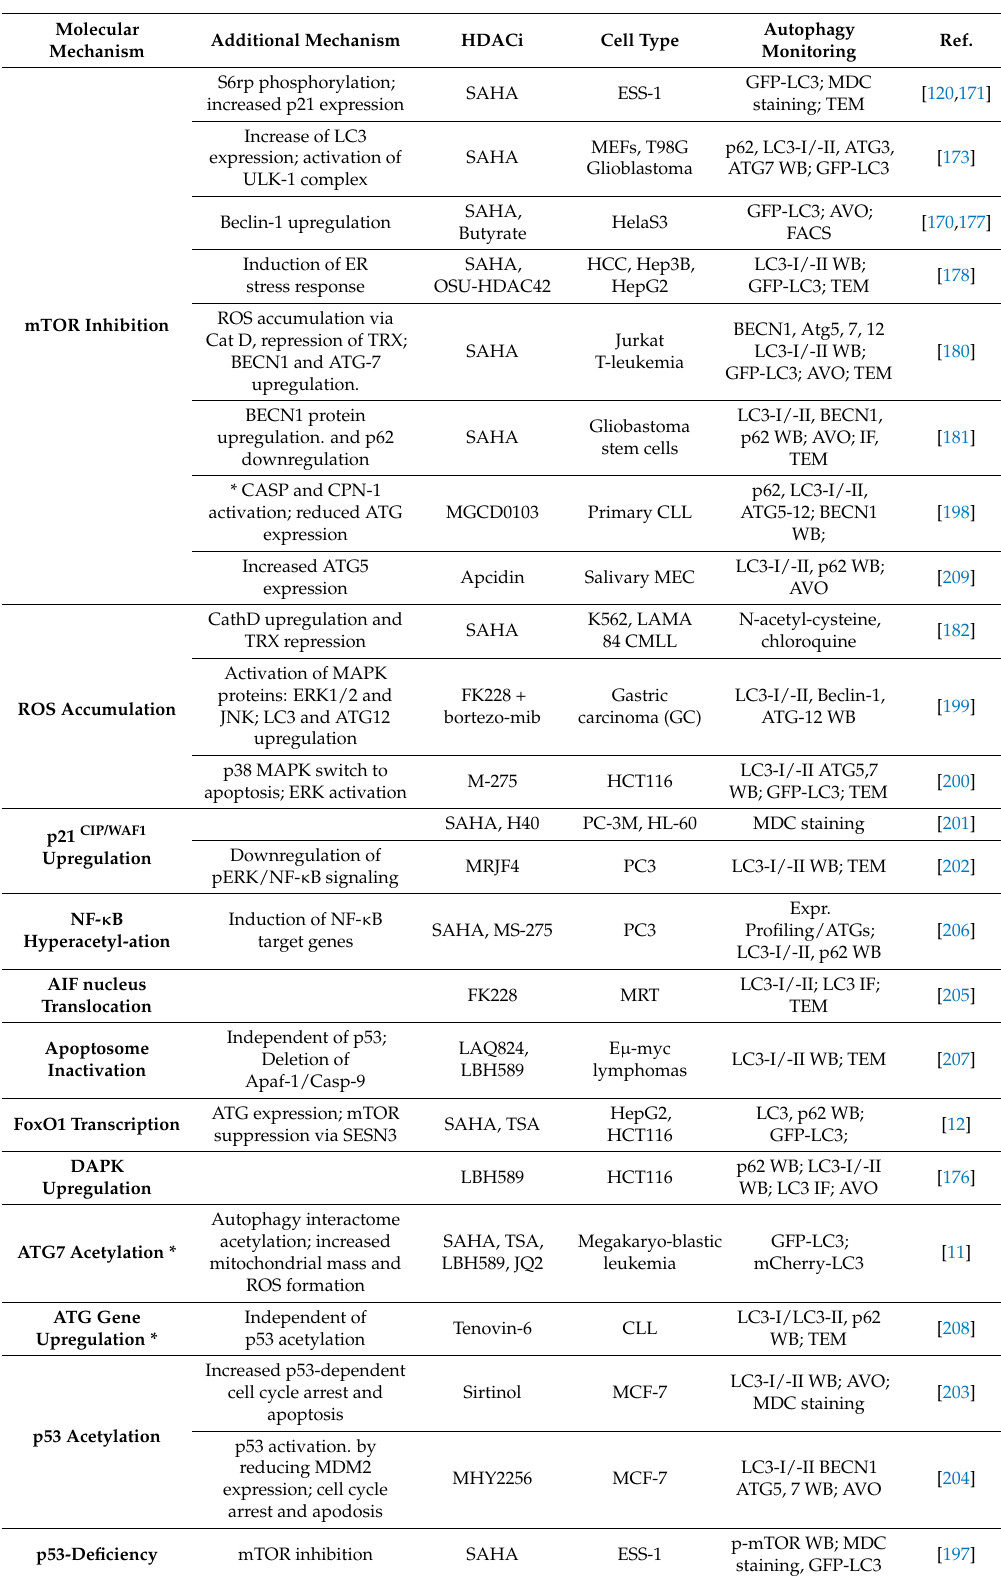
Table 2. Mechanisms of HDACi-induced autophagic cell